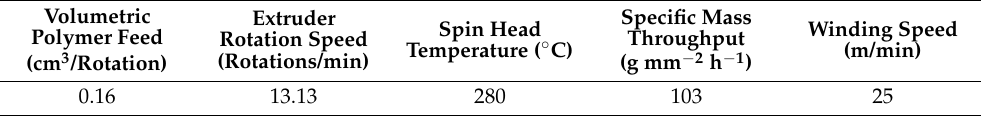
Figure 2. HF cross-sections. Table 2. Setup and melt spinning parameters of the PMP HF